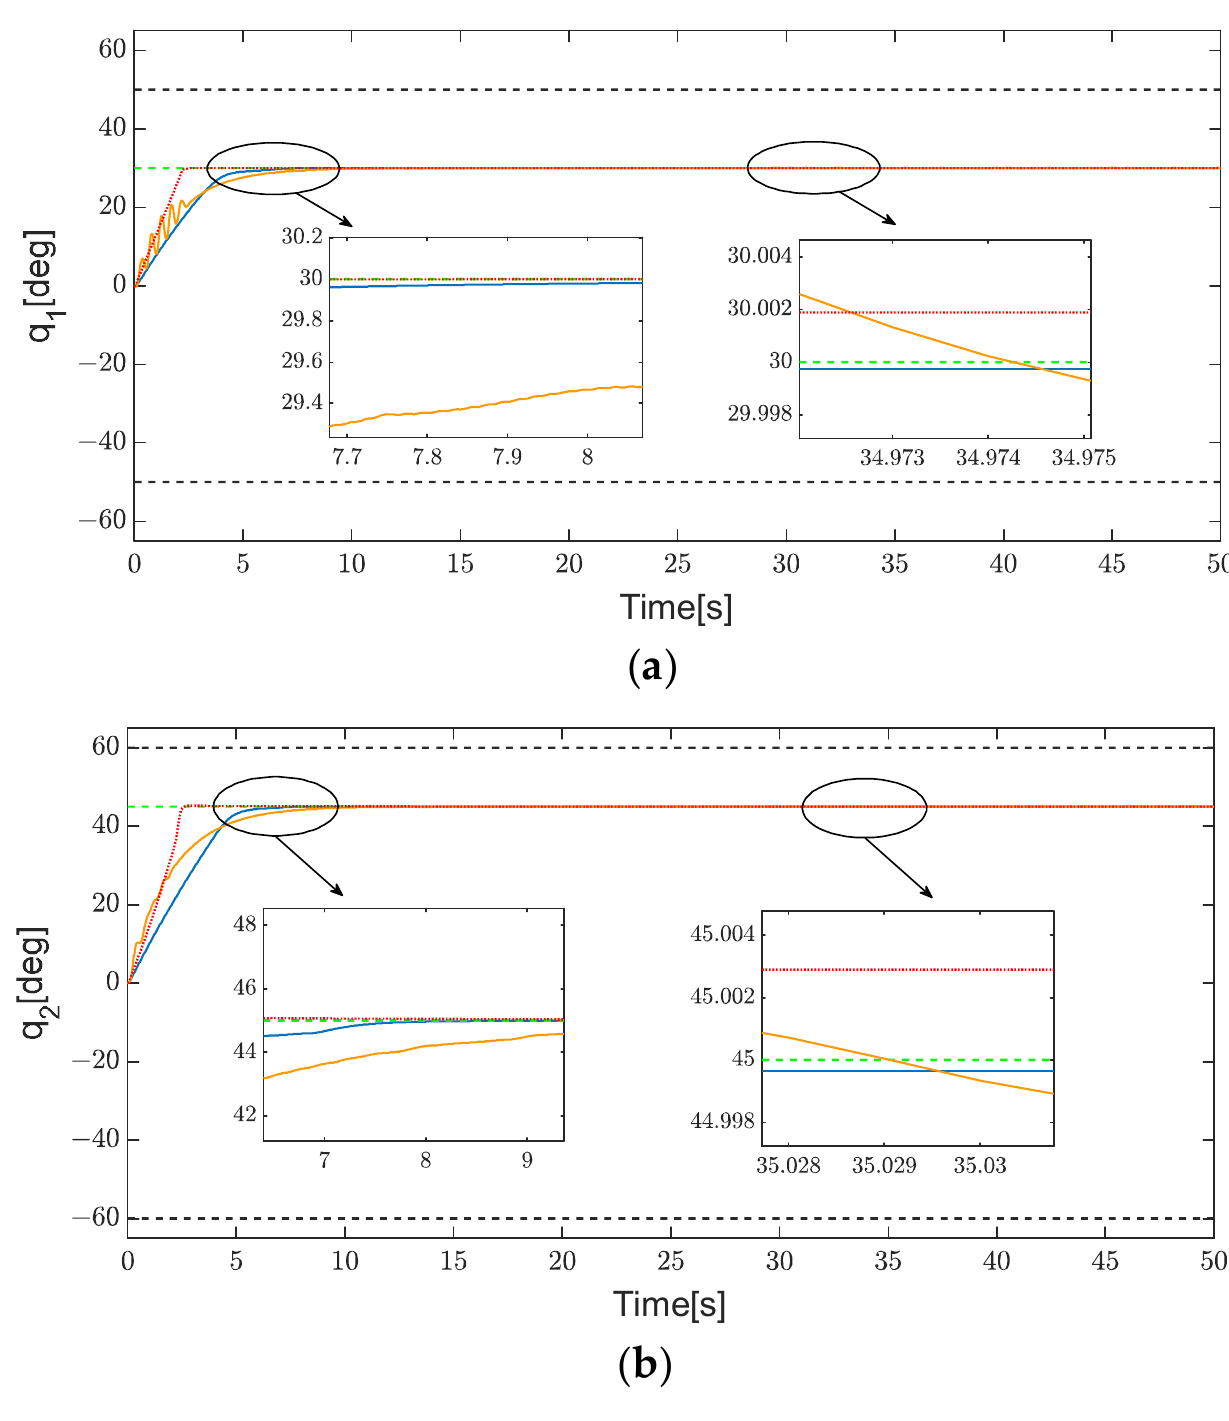
Figure 6. Comparison of angular position to [26,33] in case 1: [26] scheme (yellow solid line), [33] scheme (red dash line), the proposed scheme (blue solid line), the reference angular position (green dashed line), the angular position constrains (black dashed line); ( a ) Joint 1. ( b ) Joint 2.